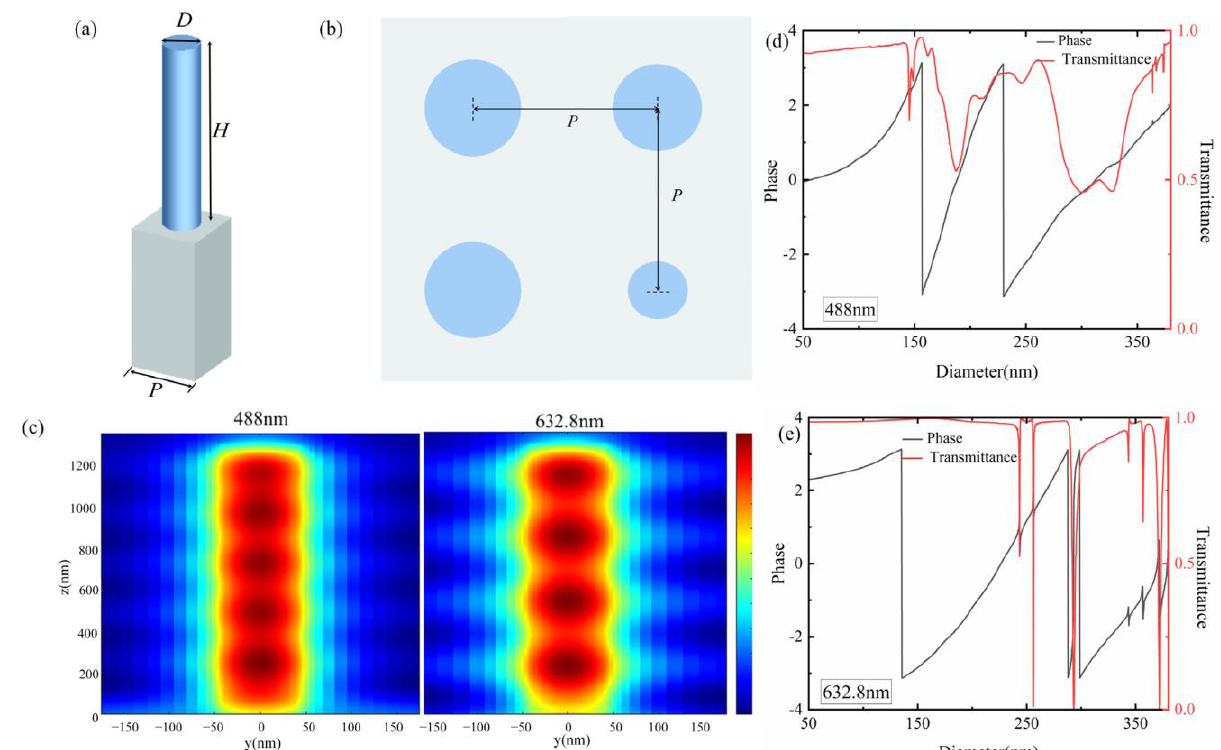
Figure 1. ( a ) 3D view of the unit cells; ( b ) top view of the unit cells; ( c ) the magnetic field distribution inside the nanopillar with a diameter of 120 nm; ( d ) the phase and transmittance of the unit cell of 488 nm; ( e ) the phase and transmittance of the unit cell of 632.8 nm.